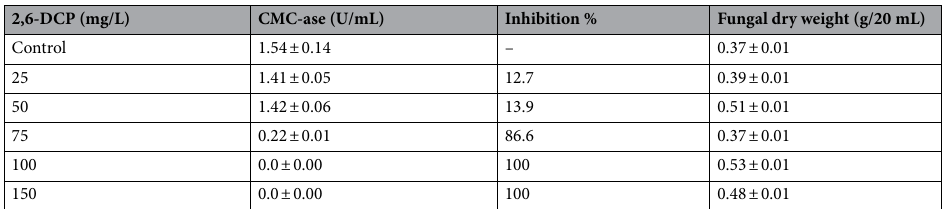
Table 1. Carboxymethyl cellulase (CMC-ase) production by fungal isolate grown under different 2,6-DCP concentrations, after 7 days of incubation. Results are represented as means ± standard error (SD) of three